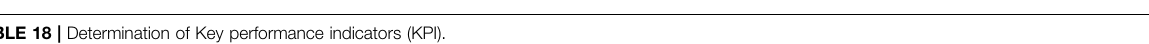
TABLE 18 | Determination of Key performance indicators